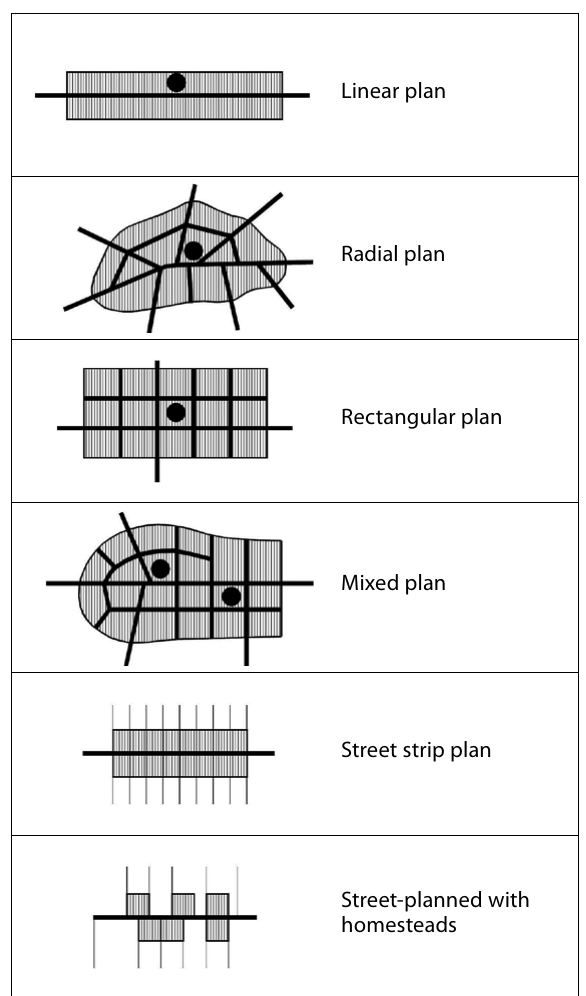
fig. 2. The country‘s settlements selected for the research of spatial structure and explored in place